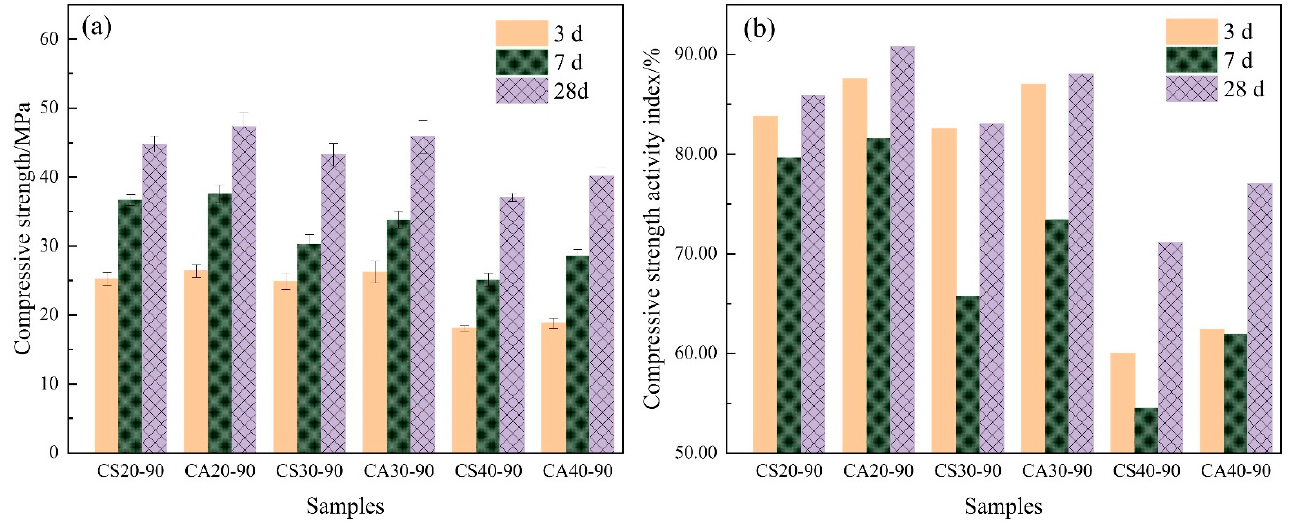
Figure 4. Effect of coupled mechanical–chemical activation on hydration activity of copper slag powder composite cement samples. ( a ) Compressive strength; ( b ) compressive strength activity index.